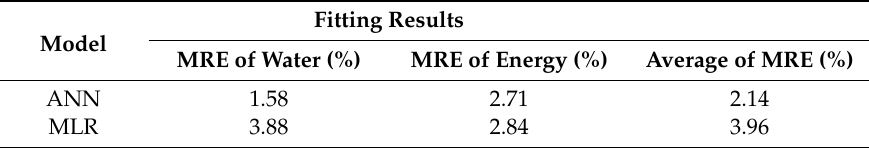
Table 5. Comparison of the two models. MRE = mean relative